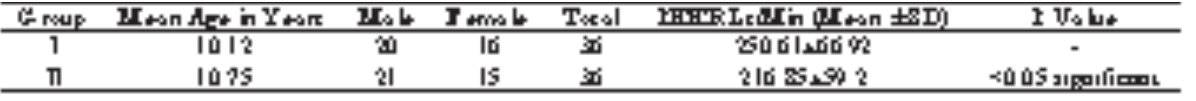
Table I : Peak Expiratory Flow Rate in controls and patients with Adenotonsillar